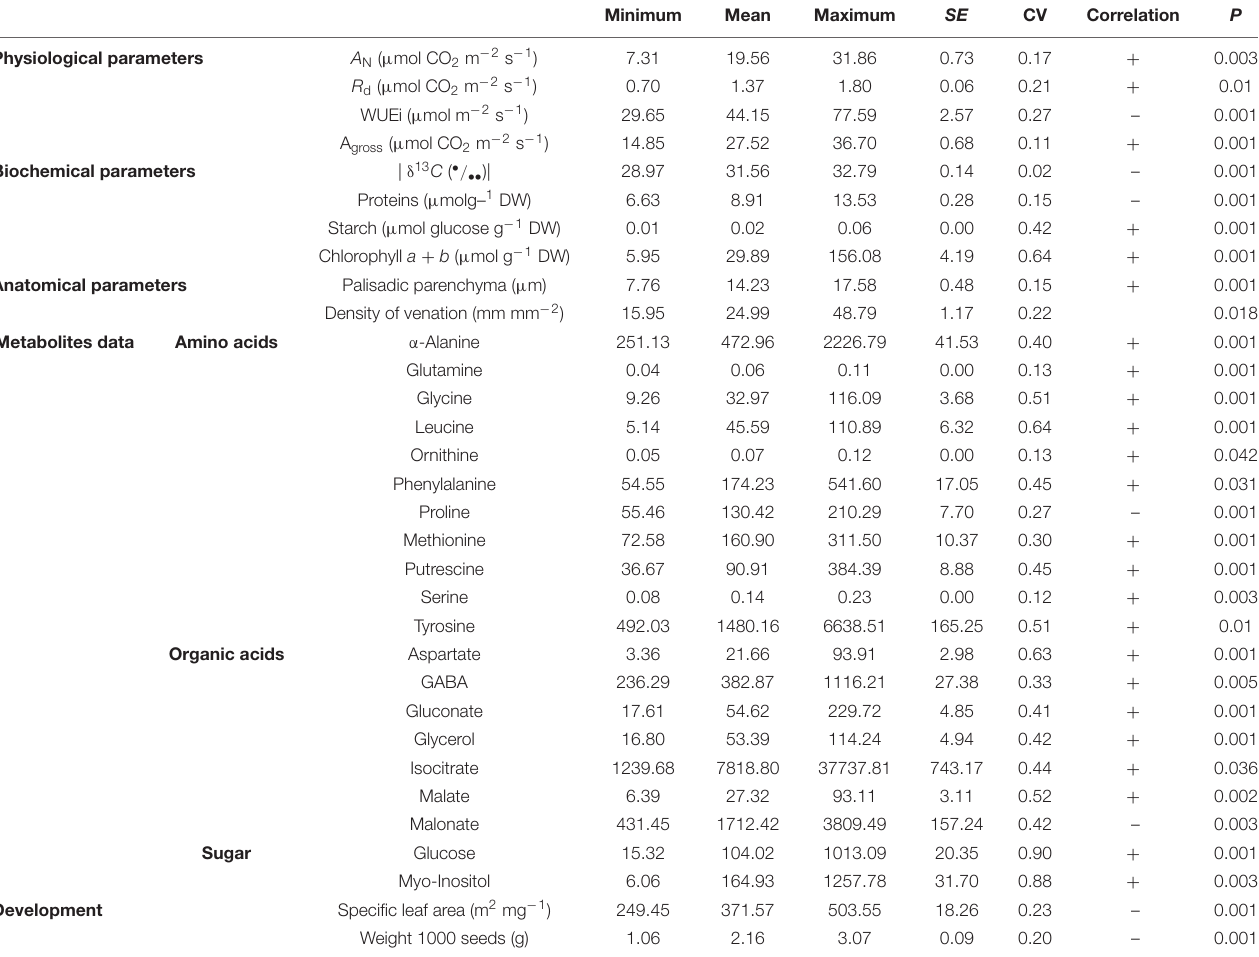
TABLE 1 | Variables that were significant ( p < 0.05) in PGLS model with genome size.